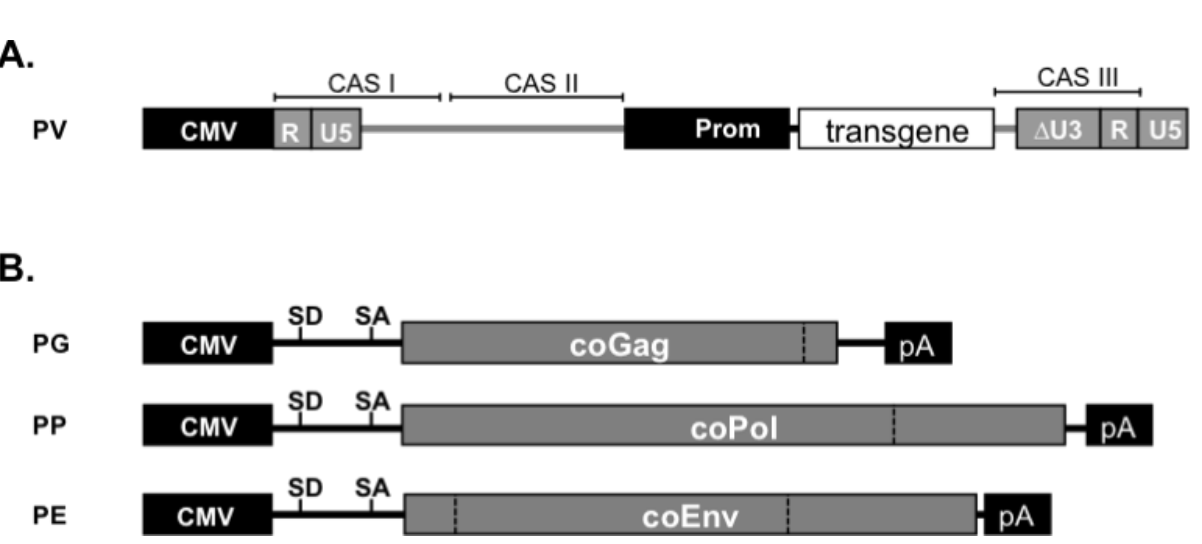
Figure 4. Third generation Prototype FV (PFV) vector system. Schematic outline of the third generation ( A ) transfer vector PV and ( B ) packaging expression vectors for codon-optimized (co) Gag (PG), coPol (PP), and coEnv (PE). CMV: